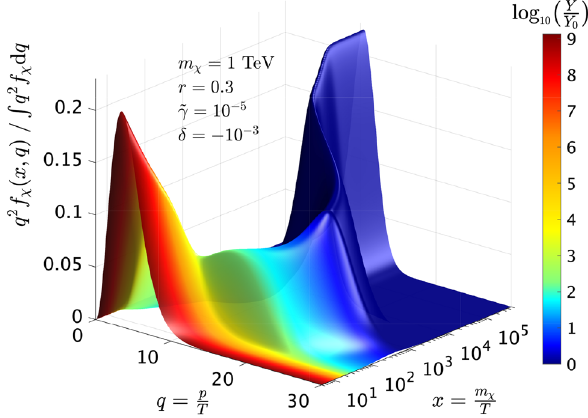
Fig. 4 Time evolution of the phase-space density f χ ( x , q ) , computed by the fBE approach. The color scale shows the DM abundance Y ( x ) , in units of its final value, which reflects the overall normalization of f χ . This example is for a case of DM annihilation through a narrow reso- nance and an early kinetic decoupling (with model parameters stated in the legend). The coupling strength is set to ρ = 1 . 13 × 10 − 2 in order to satisfy2 (Ω χ h 2 ) fBE = Ω DM h 2 .Theinitialequilibriumphase-spacedis- tribution is strongly distorted during chemical and kinetic decoupling, and finally remains in a highly non-thermal